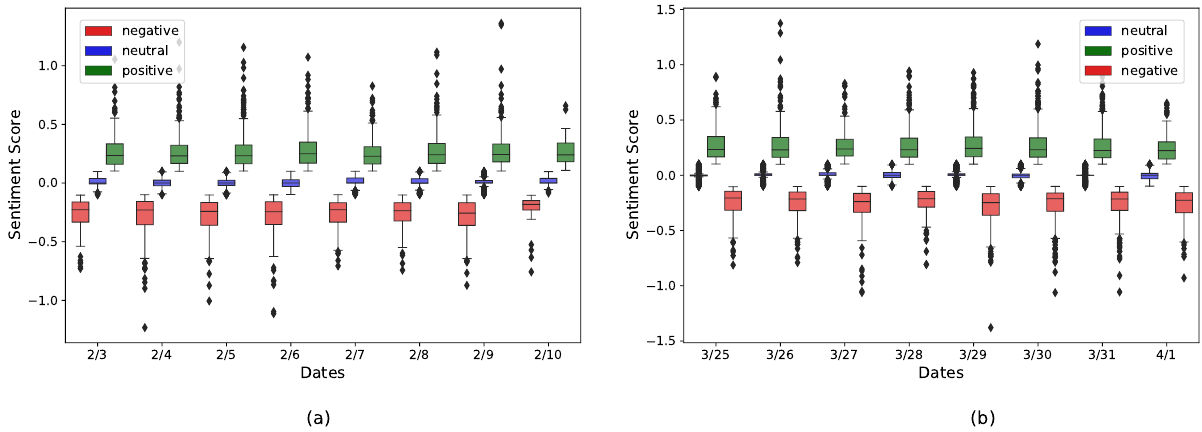
Figure 8. Boxplots for the sentiment scores. ( a ) February 2021 sentiment scores. ( b ) March 2021 sentiment